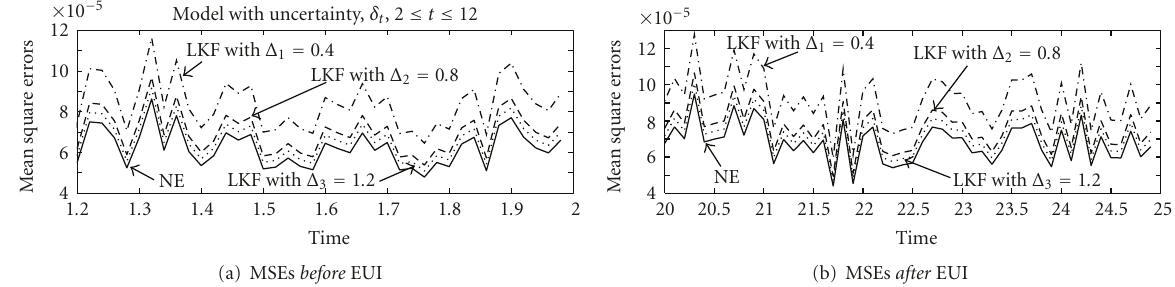
Figure 4: MSEs comparison between NE-DFRHF and three LRHKFs before and after EUI.